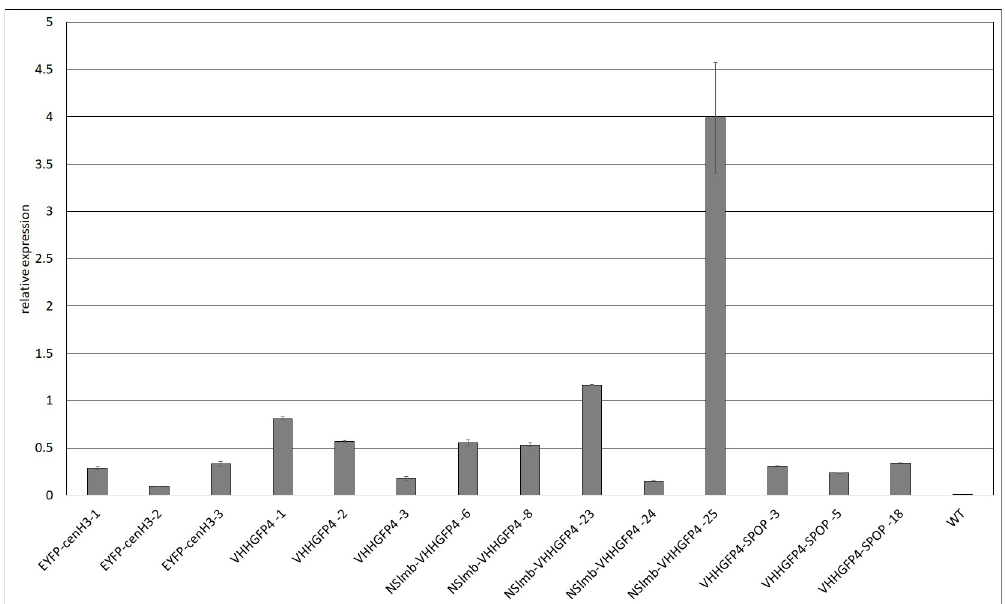
Fig 2. Quantitative EYFP-CENH3 transcript analysis of transgenic N . tabacum lines using qRT-PCR. Three independent transgenic lines of each genotype were tested for relative EYFP-CENH3 expression. The mRNA levels for EYFP-CENH3 varied between 0.2 and 1.2, except for the NSlmb-VHHGFP4 Line 25 with a value of 4. Fluorescence microscopy analysis confirmed that the high abundance of transcript in line 4 corresponds to the high amount of fusion protein (S3 Fig). Three biological and three technical replicates were analysed for each tested plant